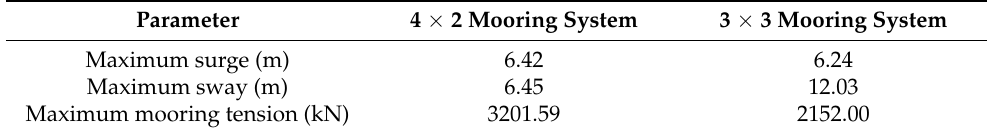
Table 8. The motion response